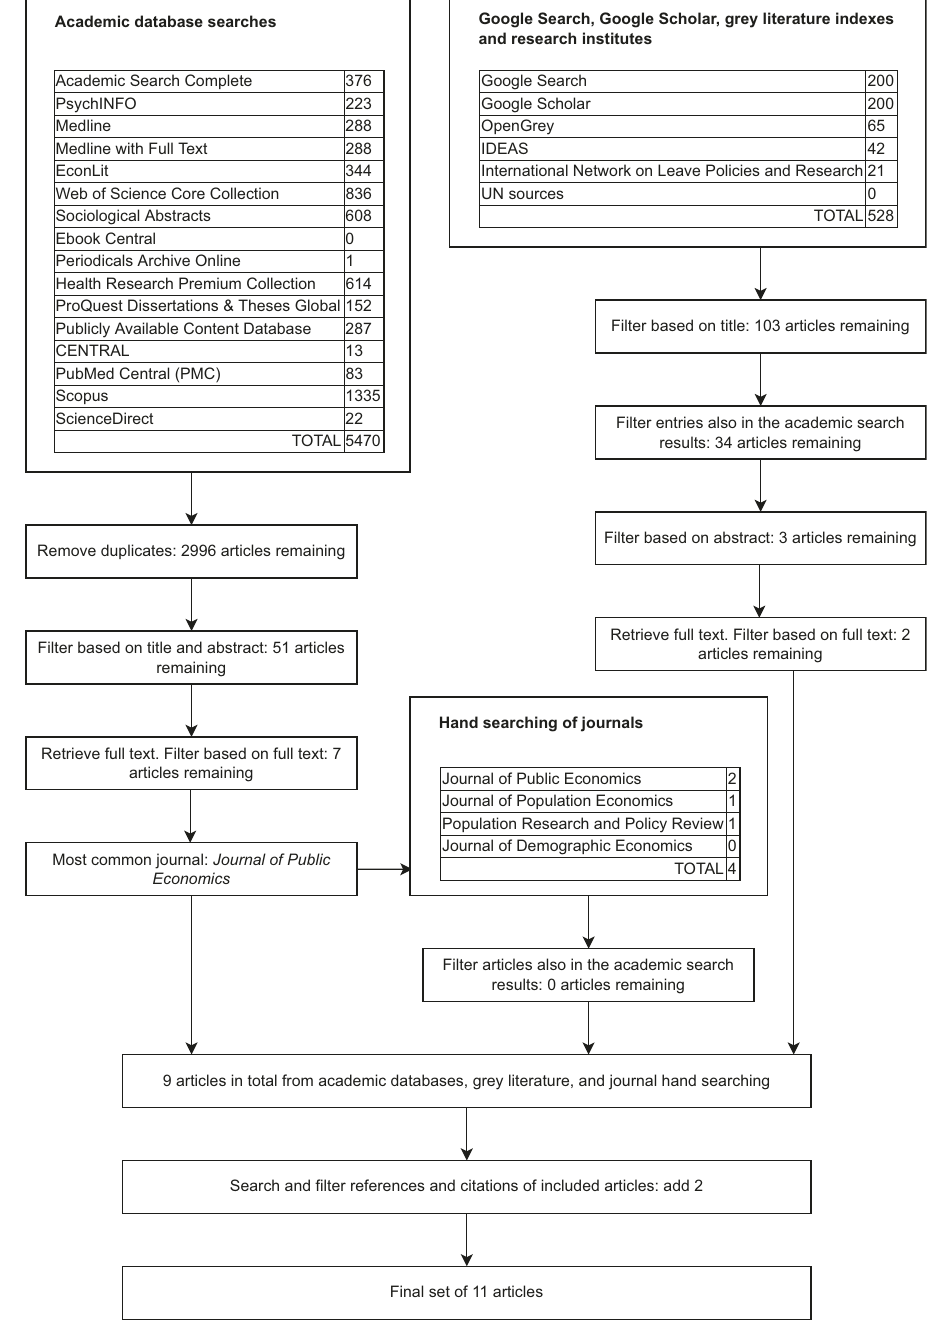
Fig. 1 The literature searching and fi ltering process. Boxes indicate the sources used and fi ltering